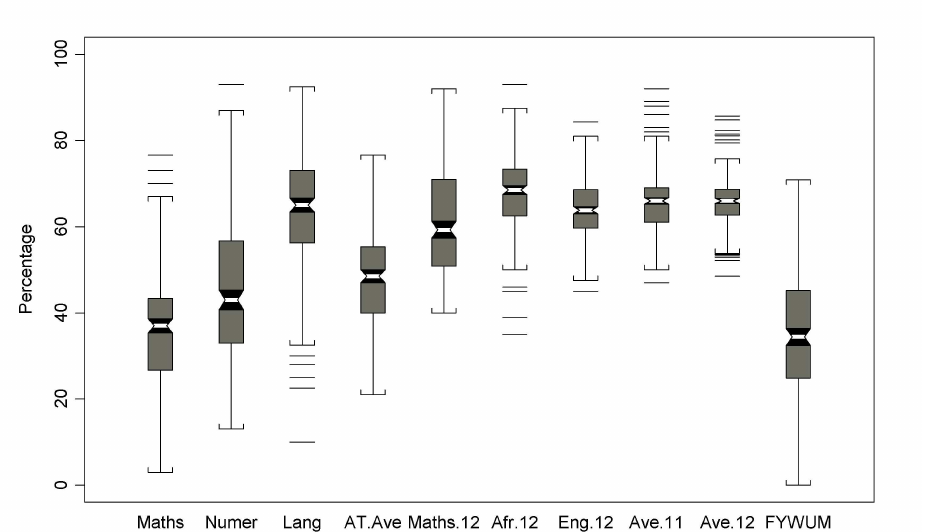
Figure 2: Notched boxplots of the variables of the Test Battery 2 data set for the 2000 intake